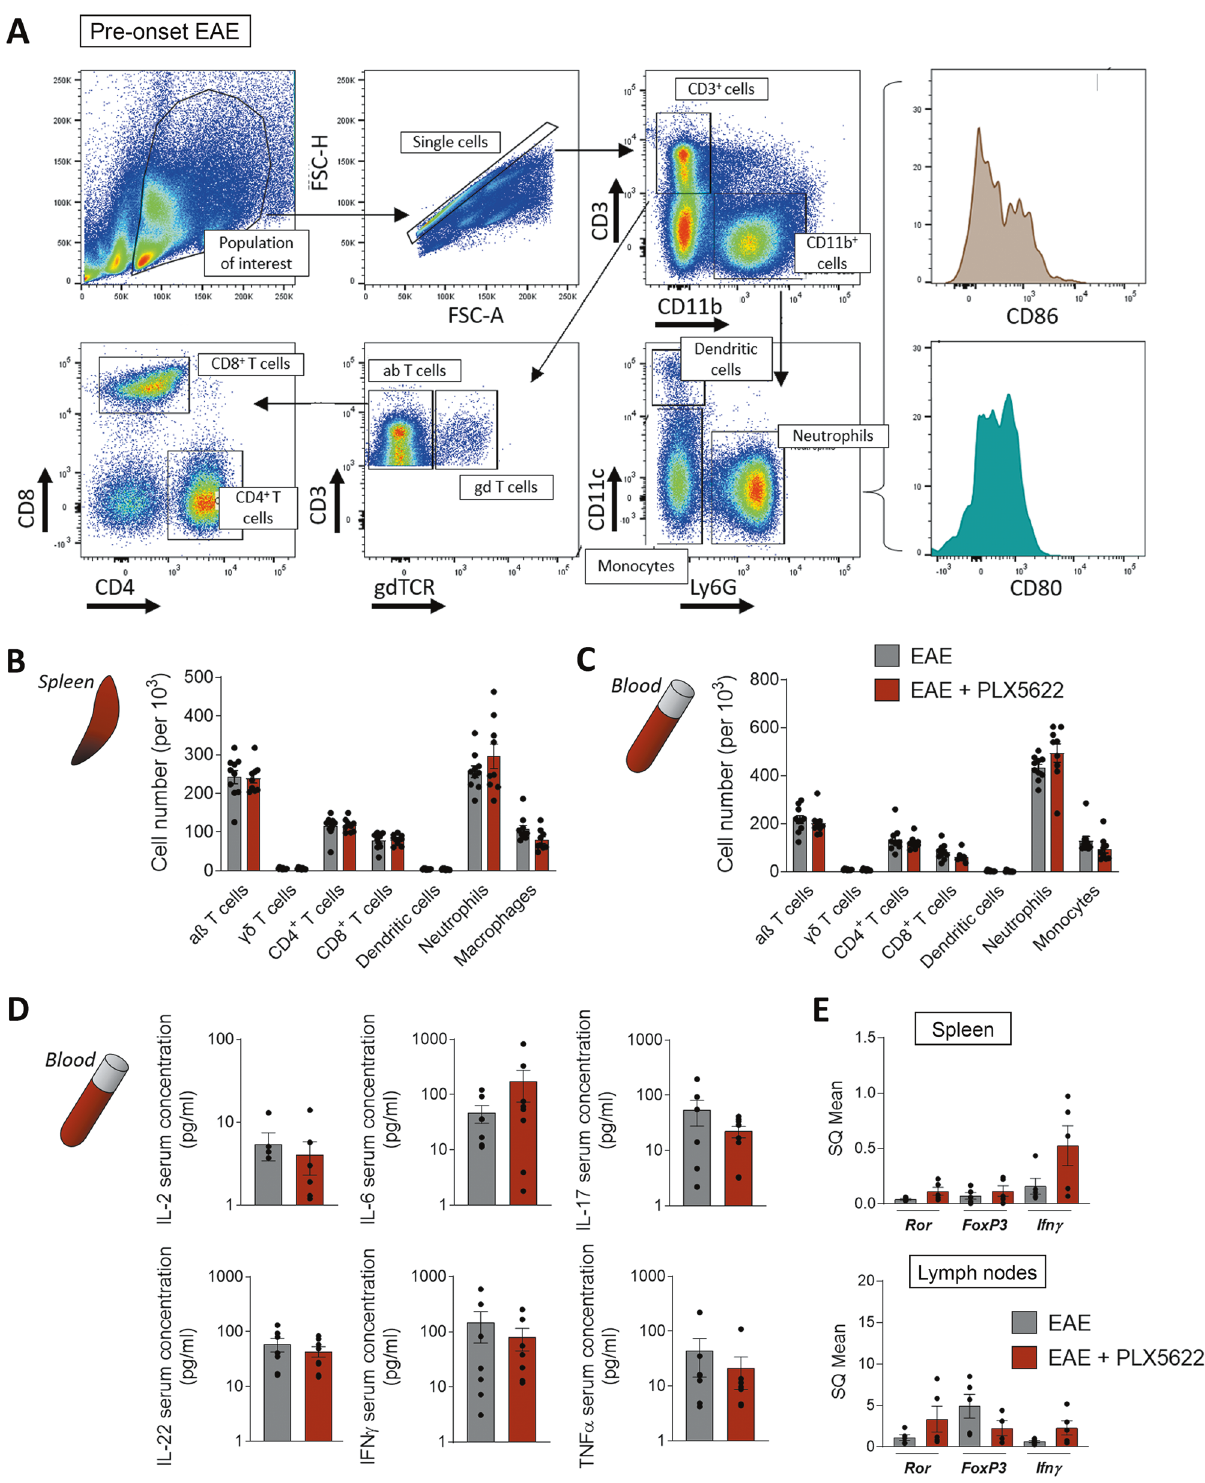
Fig. 3 PLX5622 does not alter peripheral immune priming after immunization. A Flow cytometry gating strategy for analysis of immune populations in the spleen and peripheral blood of mice at EAE pre-onset (dpi 8 – 9). Quanti fi cation of αβ T cells (CD3 + γδ TCR - ), γδ T cells (CD3 + γδ TCR + ), CD4 T cells (CD3 + CD4 + ) CD8 T cells (CD3 + CD8 + ), dendritic cells (CD11b + CD11c + ), neutrophils (CD11b + Ly6G + ), and macrophages/ monocytes (CD11b + CD11c - Ly6G - ) populations in spleen ( B ) and blood ( C ), in relation to the total cells analyzed at this stage ( n = 10). D Concentration of cytokines in blood serum from control and PLX5622-treated mice at EAE pre-onset stage ( n = 8). E Relative mRNA expression of Ror , Foxp3 and Ifn γ in spleen and lymph nodes of both mice groups, at EAE pre-onset stage (dpi 9; n = 5). Data are presented as means ± SEM.